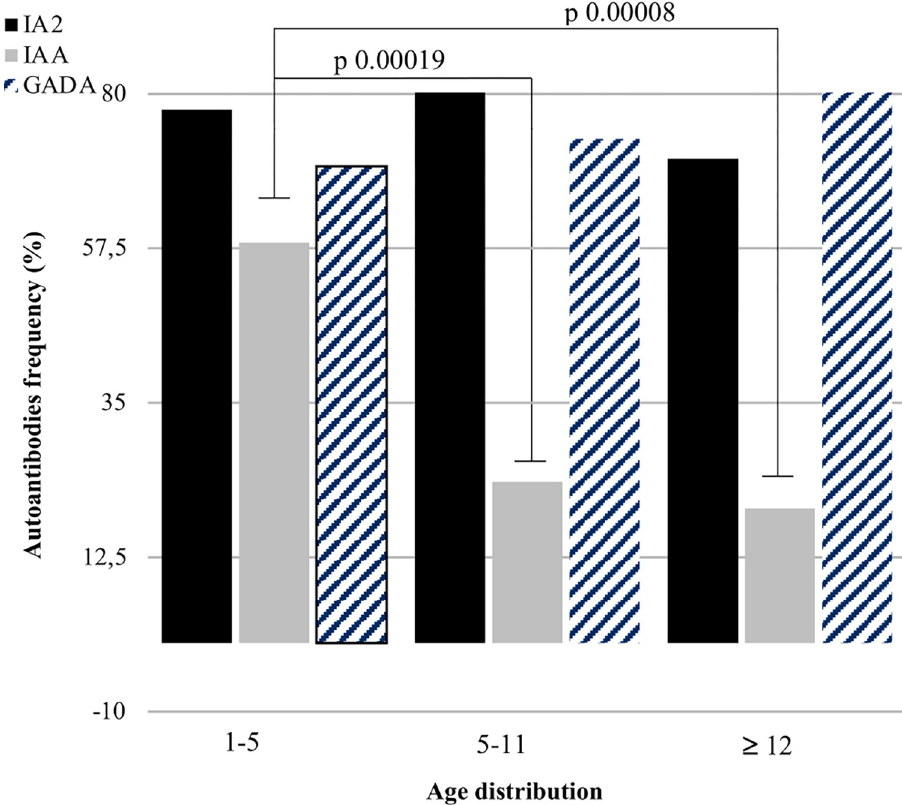
Fig 3. Autoantibodies anti-IA2, anti-IAA e anti-GAD frequencies: Age distribution.